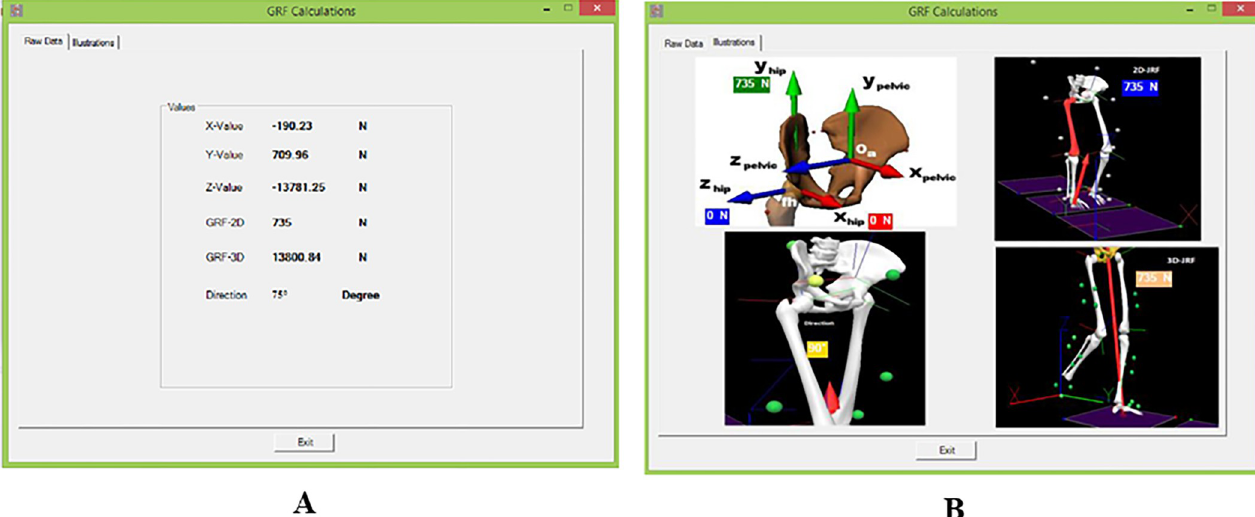
Fig 8. GRF calculation through AQHF. (A) The first window indicates raw data. (B) The second window is an illustration of raw data shown in window A.